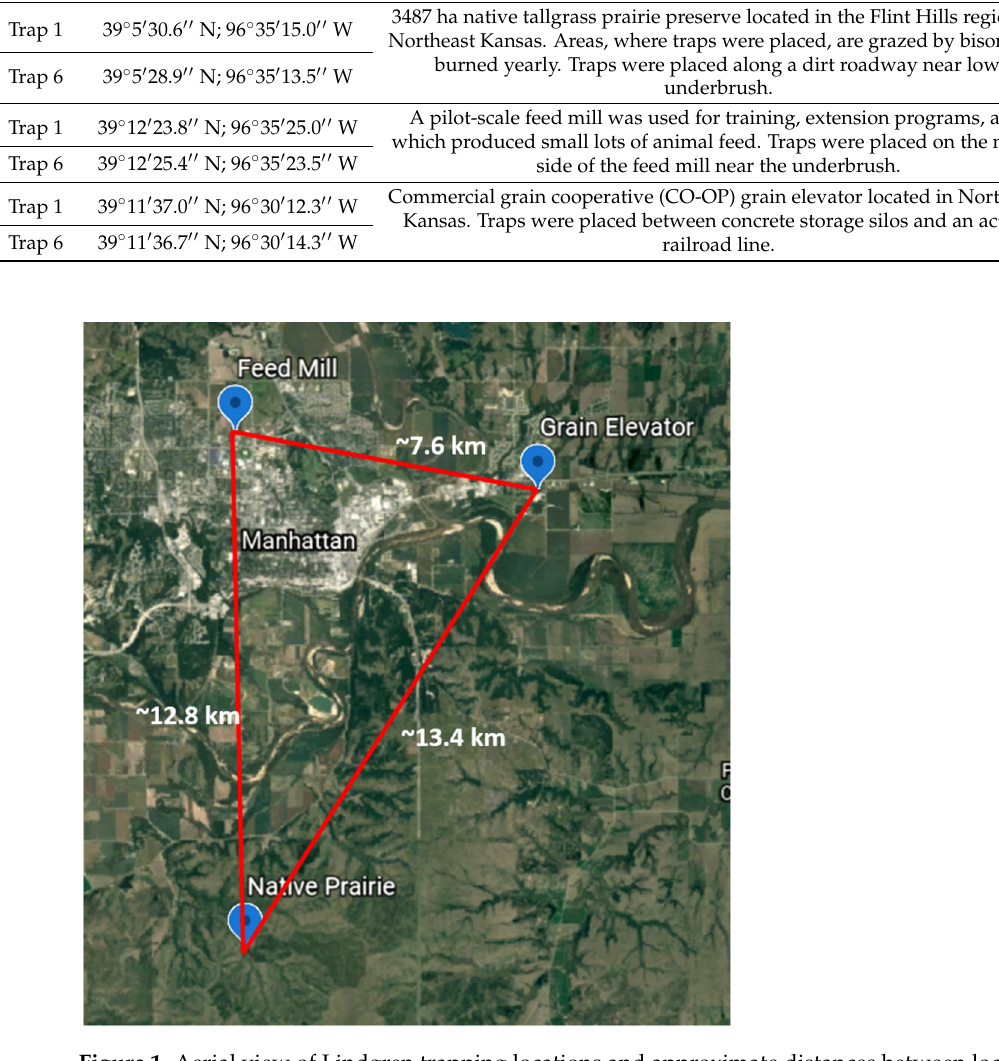
Figure 1. Aerial view of Lindgren trapping locations and approximate distances between locations (km) as estimated by Google Earth (version 9.131.0.1, earth.google.com (accessed on 8 August 2021)).